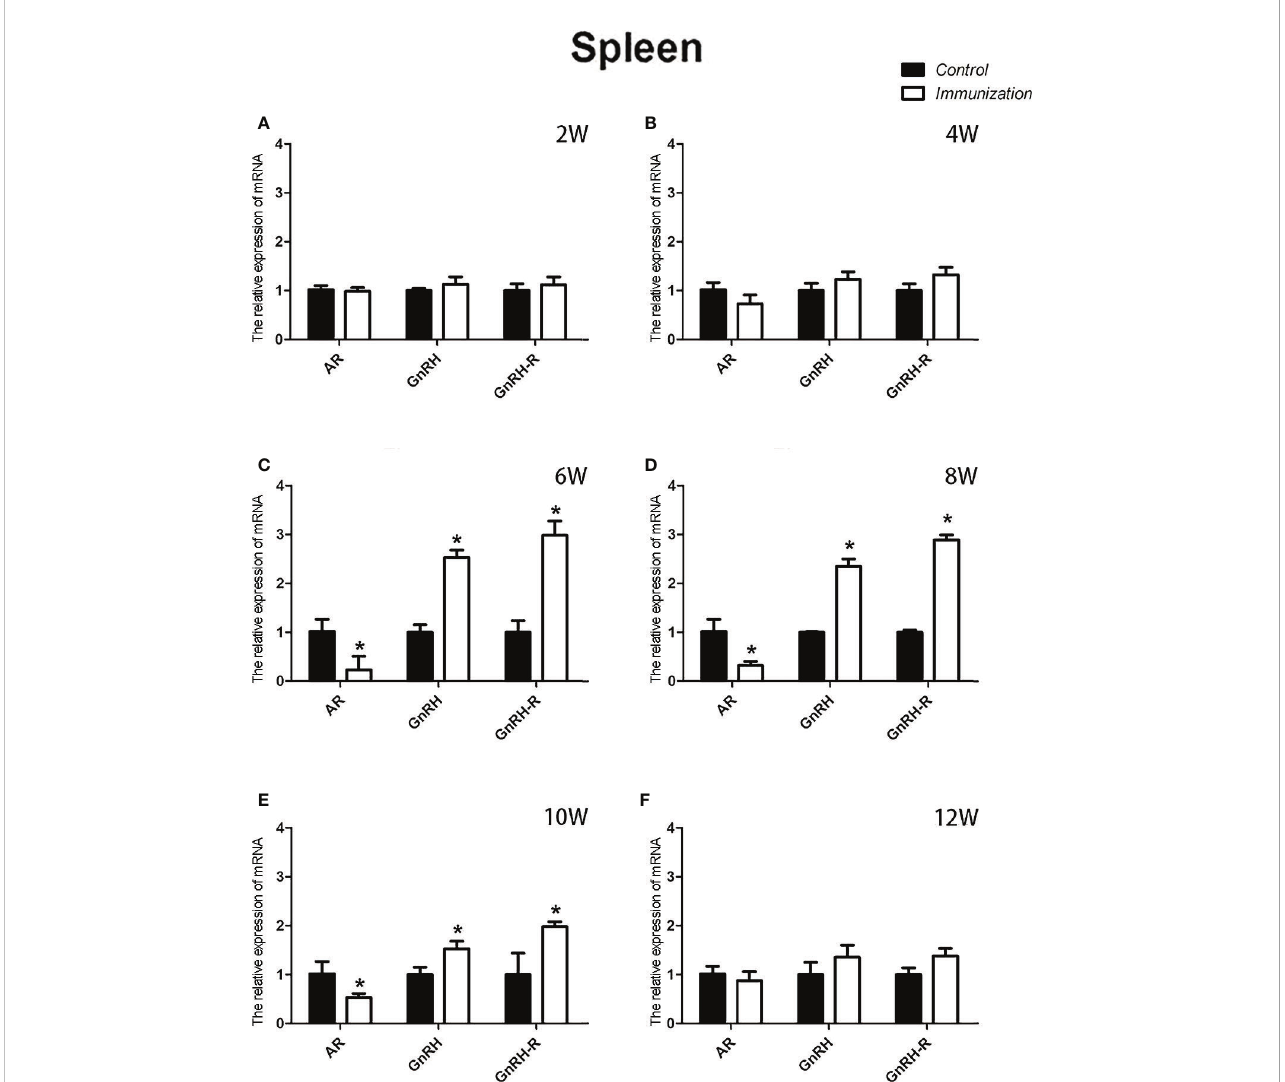
FIGURE 9 Mean ( ± SEM) effects of gonadotropin-releasing hormone (GnRH) immunization on the mRNA expression of reproduction-related genes in the spleen of the control (n = 35) and GnRH immunization groups (n = 35). (A – F) represent the detection time at different ages. * Indicates a signi fi cant difference ( P <